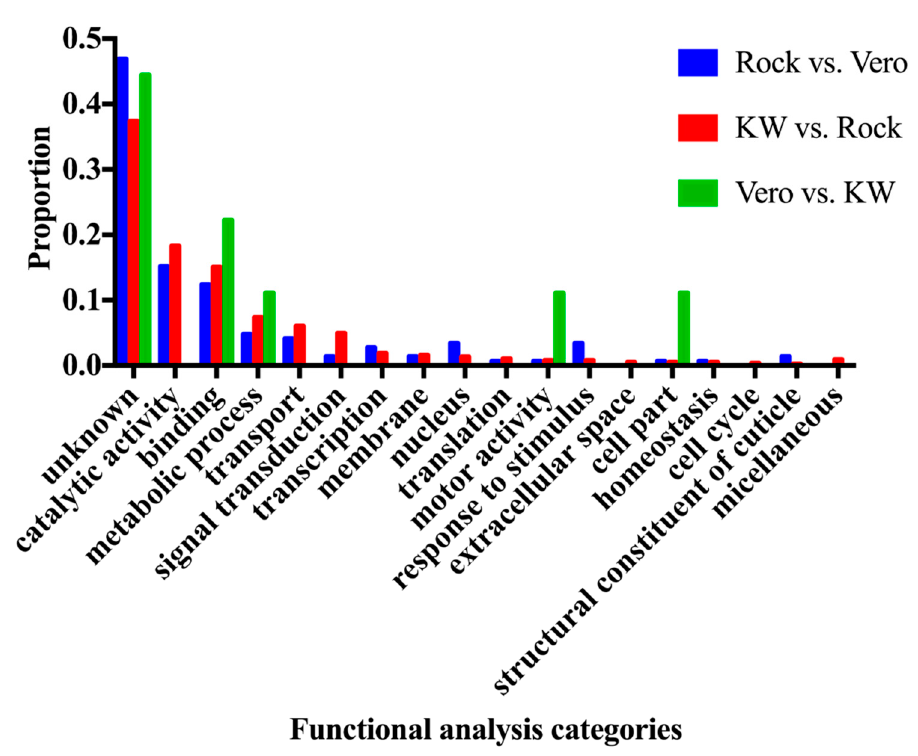
Figure 2. Comparison of three different sets of functional characterizations of significantly differentially expressed transcripts between populations ( p < 0.05).